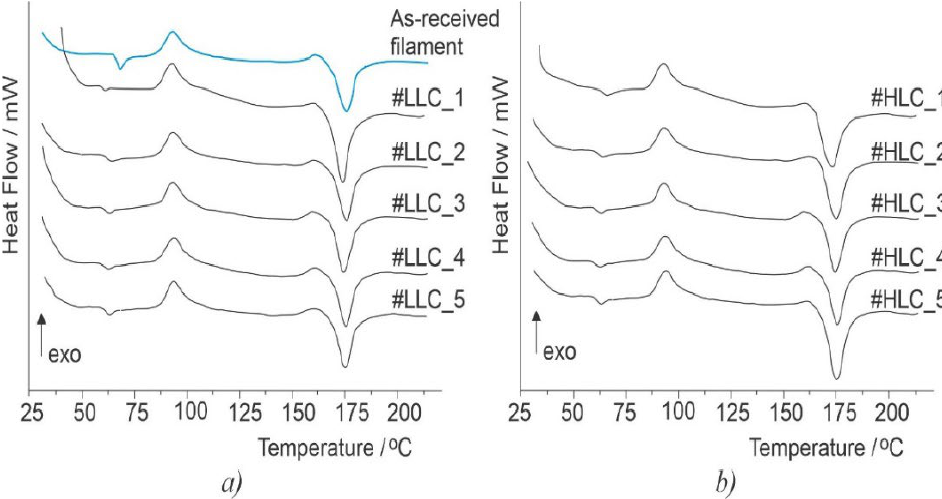
Figure 6. DSC thermograms for the LLC ( a ) and HLC samples ( b ). Figure 6. DSC curves for the LLC ( a ) and HLC samples ( b ). Table 5. Results of experimental verification for tensile strength, obtained with parameter settings from dual-response optimization for LLC scaffolds (Figure 1).